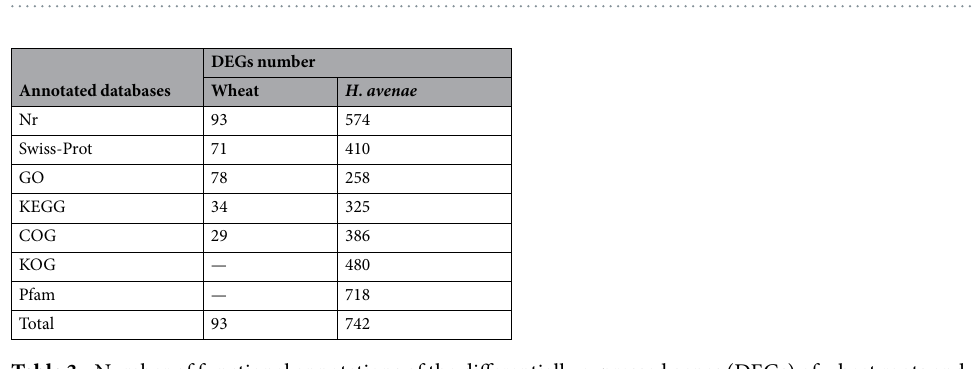
Table 3. Number of functional annotations of the differentially expressed genes (DEGs) of wheat roots and Heterodera avenae , respectively, in the